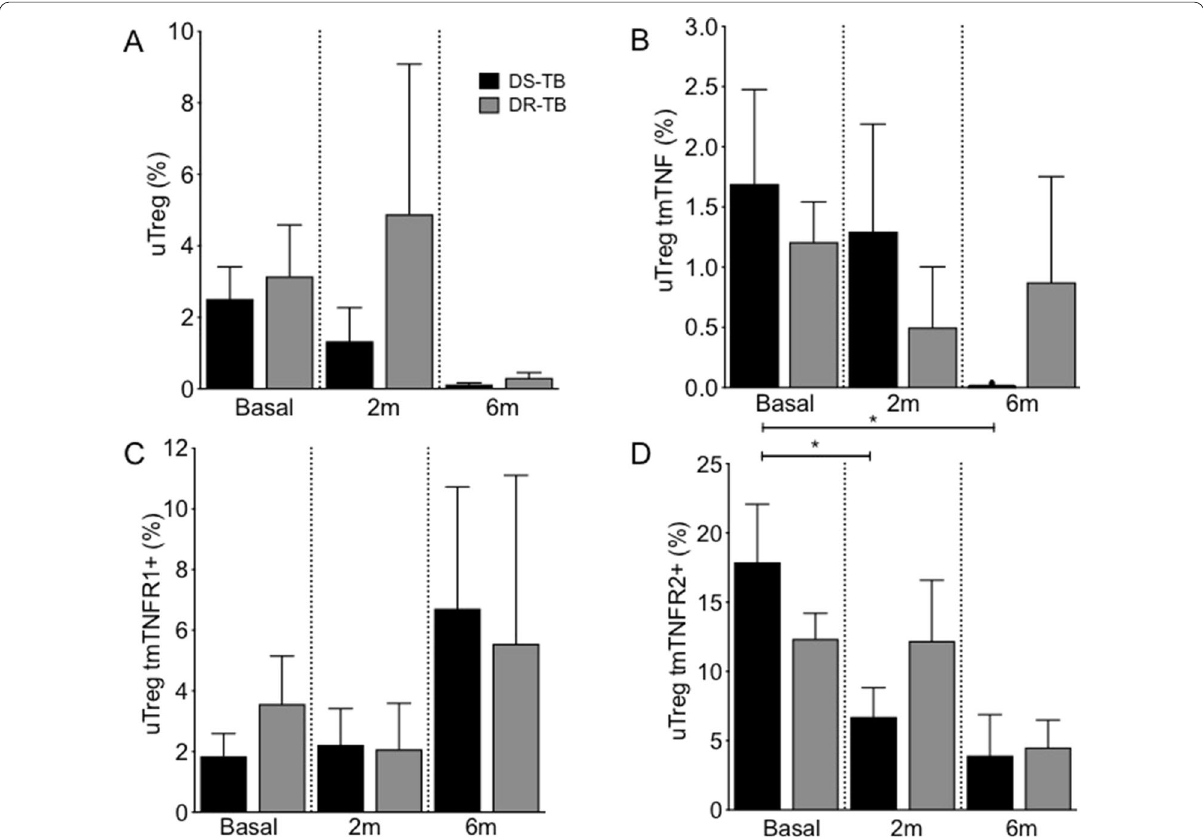
Fig. 2 uTreg TNF and uTreg TNFR2 are decreased in DS‑TB patients in response to anti‑TB therapy. Peripheral mononuclear cells from + + drug‑susceptible (DS‑TB) and drug‑resistance (DR‑TB) tuberculosis patients were obtained at diagnosis time (basal), 2 months (2 m), and 6 months (6 m) of anti‑TB chemotherapy, and then they were prepared for flow cytometry. For analysis, a gate of CD3 CD4 CD25‑Foxp3 cells + + + (unconventional regulatory T cells, uTreg) was identified. Then, the expression of tmTNF, tmTNFR1 and tmTNFR2 on the uTreg cell surface was evaluated. A The frequency of uTreg cells was obtained at basal, 2 m and 6 m of anti‑TB therapy. The frequency of uTreg positive to tmTNF ( B ), tmTNFR1 ( C ) and tmTNFR2 ( D ) was evaluated. DS‑TB n 11, DR‑TB n 7. Bar graphs showing the mean SD. One Way ANOVA with Dunn’s post‑test = = ± multiple comparisons tests (*p <